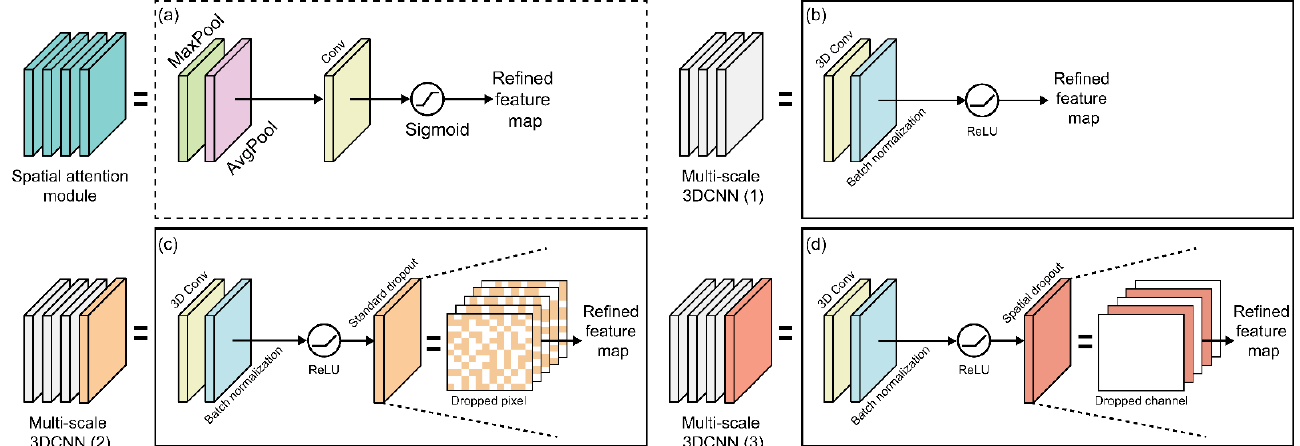
Figure 6. Multilayer 3D CNN architectures: ( a ) spatial attention module; ( b ) first architecture; ( c ) sec- ond architecture with standard dropout approach; ( d ) third architecture with spatial dropout